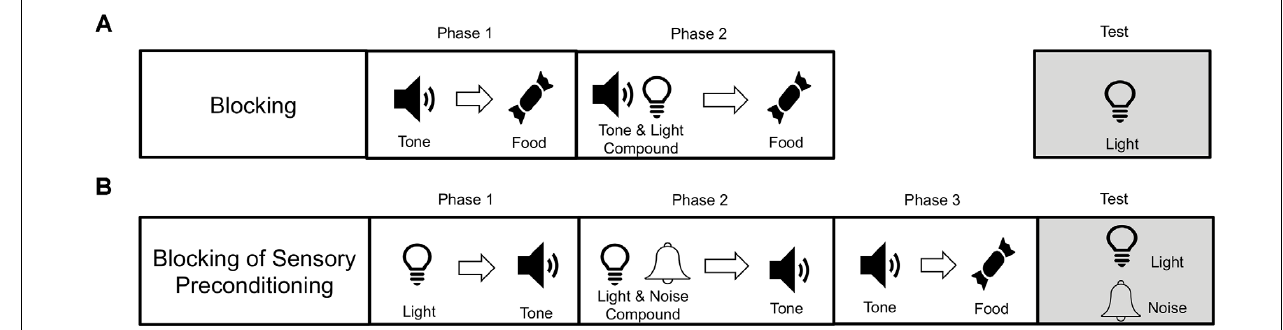
FIGURE 2 | Procedural paradigms for blocking and blocking of sensory preconditioning. (A) Blocking involves first pairing a stimulus (e.g., a tone) with an outcome (e.g., food). Then the tone is paired in compound with another novel stimulus (e.g., light), which leads to the same food outcome (light+tone → food). Blocking is said to occur when responding to the light is reduced as a consequence of the blocking procedure. (B) Blocking of sensory preconditioning is when subjects first learn that two neutral stimuli are related in time (e.g., light → tone). Then the light is presented in compound with another neutral stimulus (e.g., noise), and this leads again to the tone (i.e., light+nois → tone). Like blocking with food rewards, this procedure also reduces the sensory preconditioning effect. This demonstrates that the tone can serve as a sensory-specific prediction, which can be blocked, much like a food reward that has inherent value. This supports the idea that SPC is mediated by a representation of a sensory-specific relationship between the tone and